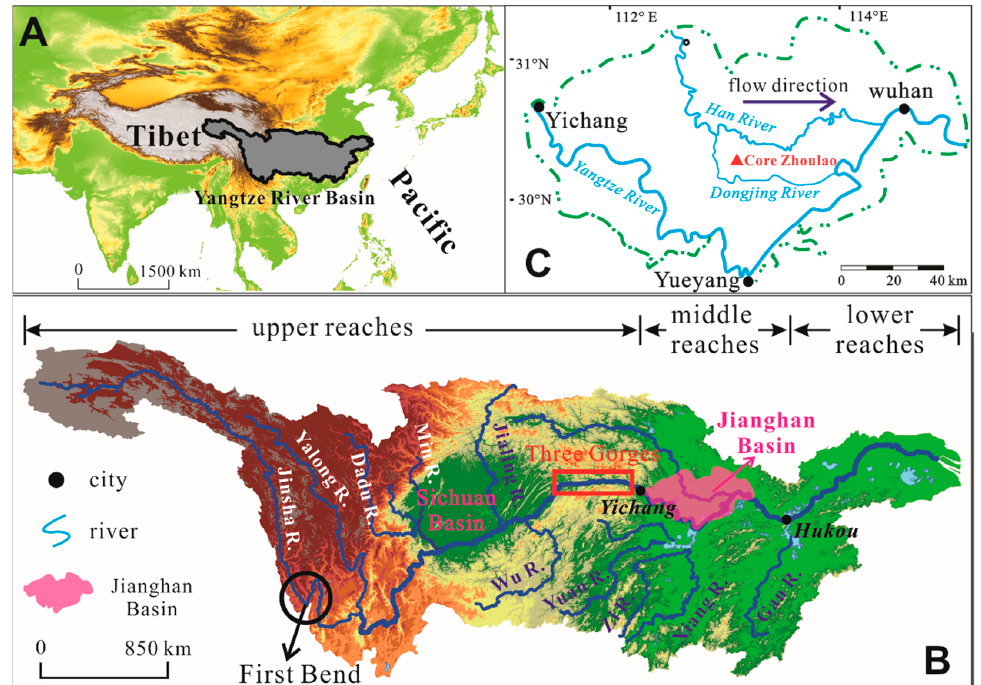
Figure 1. Sketch map showing the locations of the Yangtze River Basin ( A ), Jianghan Basin ( B ), and the Zhoulao borehole ( C ). ( A ) The Yangtze River originates from the Tibetan Plateau and discharges into the Pacific; ( B ) locations of the two key capture points during the evolution of the Yangtze: the First Bend (black circle) and the Three Gorges (red rectangle). Additionally shown are the locations of the Sichuan and Jianghan basins located to the west and just downstream of the Three Gorges, respectively; ( C ) location of the Zhoulao borehole in the depo-center of the Jianghan Basin. The Jianghan Basin, located just below the outlet of the Three Gorges [25] (Figure 1b), is the closest and most sensitive depocenter related to the incision of the Three